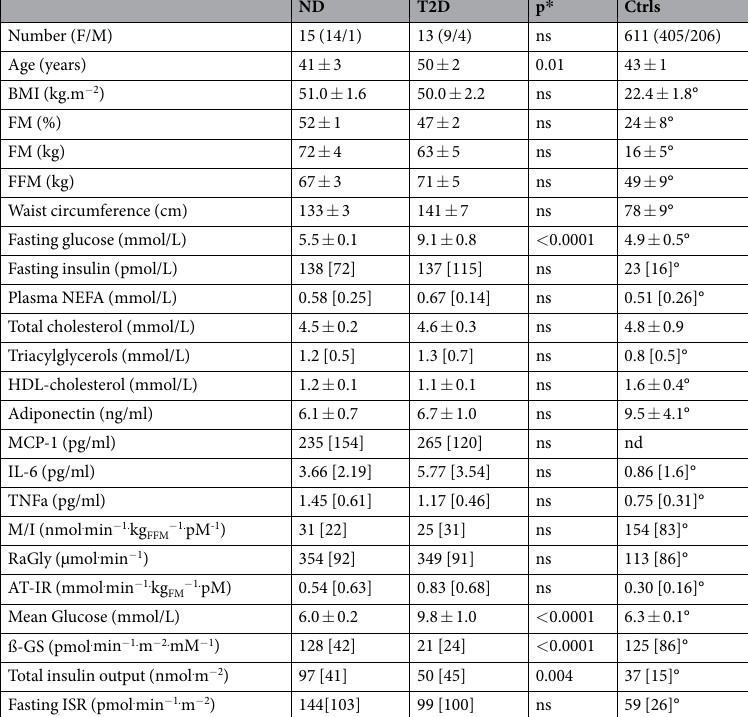
AT-IR (mmol . min − 1. kg FM − 1. pM)